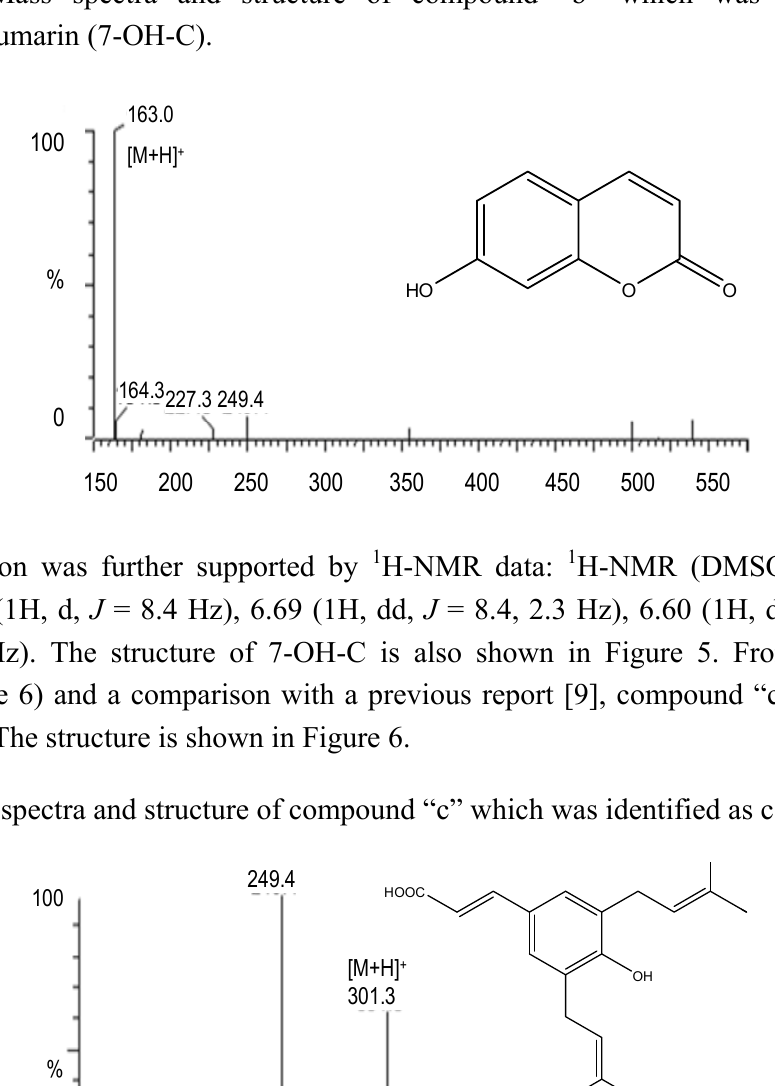
Figure 5. Mass spectra and structure of compound “b” which was identified as 7-hydroxycoumarin (7-OH-C).